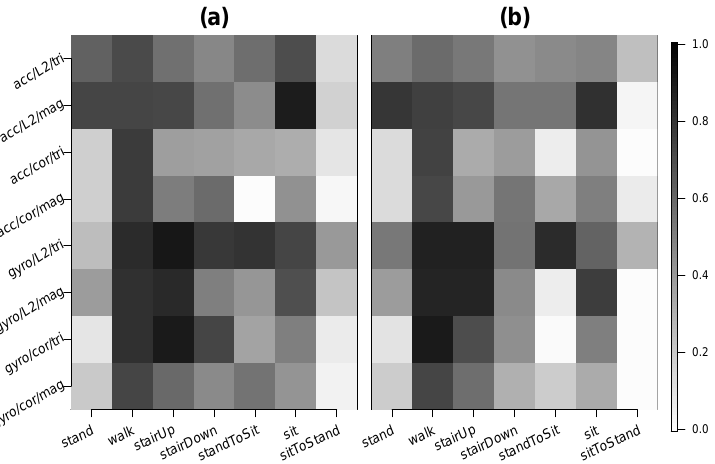
Figure 4. Average sensitivity across subjects for the primary test data segment (Steps 1, 2, 5, and 6). Panel ( a ) corresponds to the smartphone in the front pocket, and Panel ( b ) to the smartphone in the back pocket. For each panel, the columns are the different activities during the test data collection. Each row is a unique combination of sensor type (accelerometer or gyroscope), distance metric ( L 2 distance or correlation), and data type (tri-axial or magnitude). As shown in the legend at the right, the higher the average sensitivity the darker the